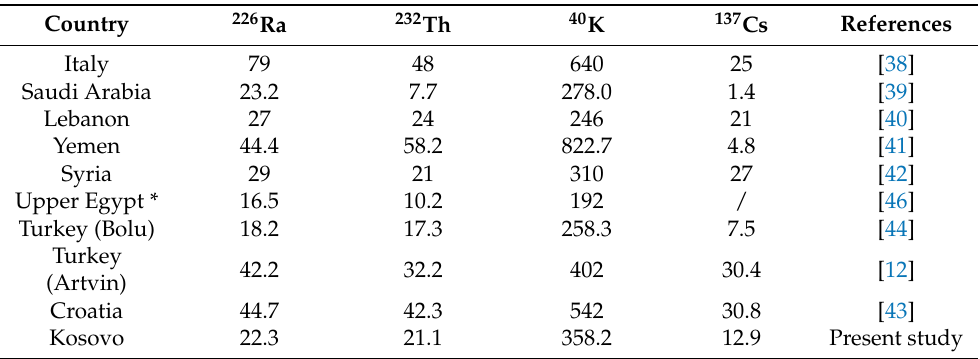
Table 1. Comparisons of specific radionuclide concentrations by countries